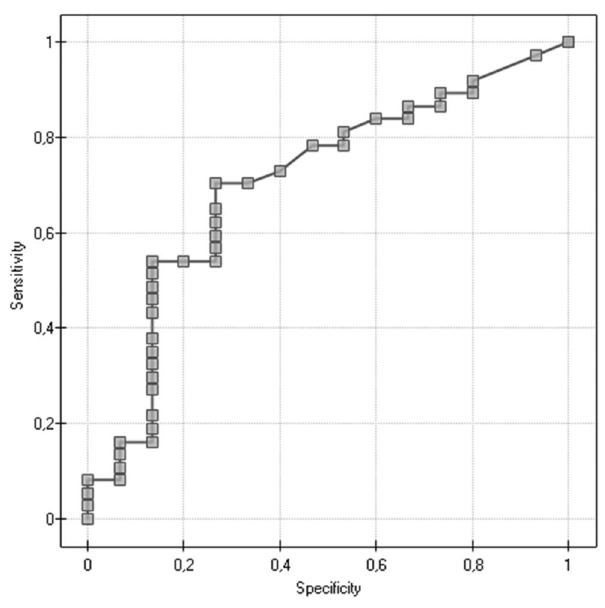
Figure 1. Prediction of death within five years for the variable inhibin B (pg/mL).